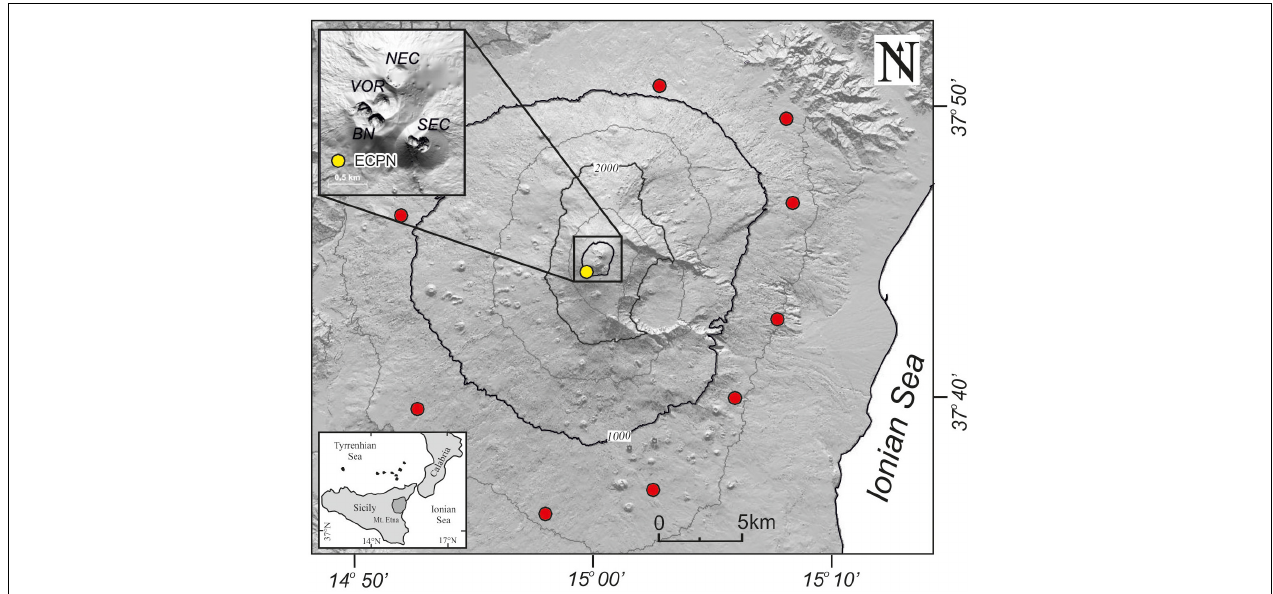
FIGURE 1 | Map of Mt. Etna with location of the FLAME scanning spectrometers network (red-solid circles) and the Etna Cratere del Piano (ECPN) seismic station used for this study (yellow-solid circle). The shaded relief on the upper left corner details the volcano four-summit craters (VOR, BN, SEC, and NEC) and the ECPN station. In the bottom left is showed the geographic location of Mt. Etna and